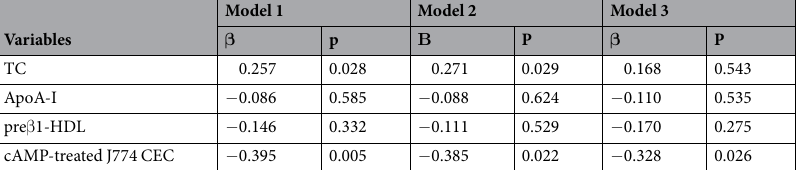
Table 4. Multivariate linear regression (MLR) with cIMT as independent predictor in NAFLD patients. Model (1) MLR with all correlated parameters. Model (2) Adjusted MLR for LCAT activity, LS, FBG, THP-1 macrophage CEC and HDL-C. Model (3) Adjusted MLR for age, BMI, HOMA-IR, TG, LDL-C, HDL-C, SBP and DBP. β : Standardized